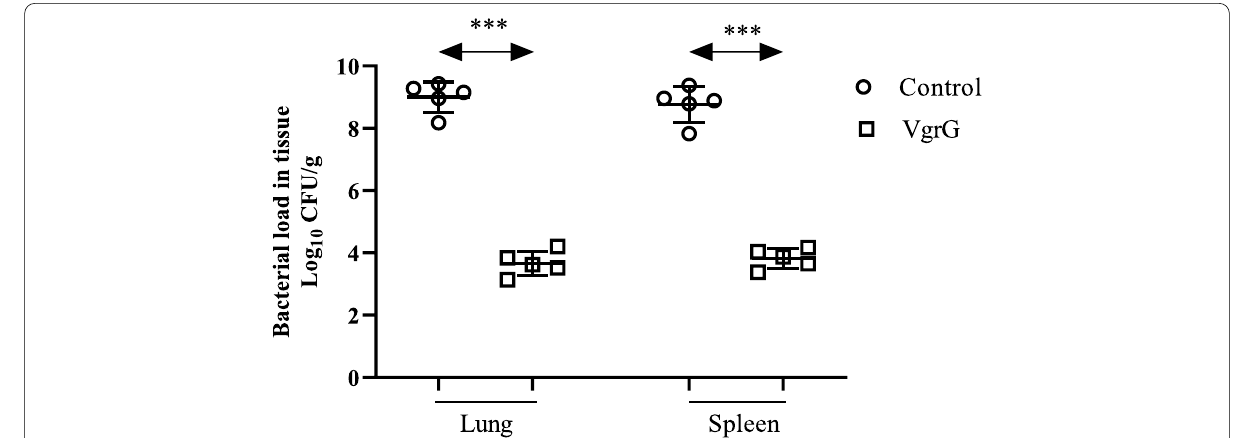
Fig. 3 Bacterial burden in the lungs and spleens of the control and actively immunized mouse groups